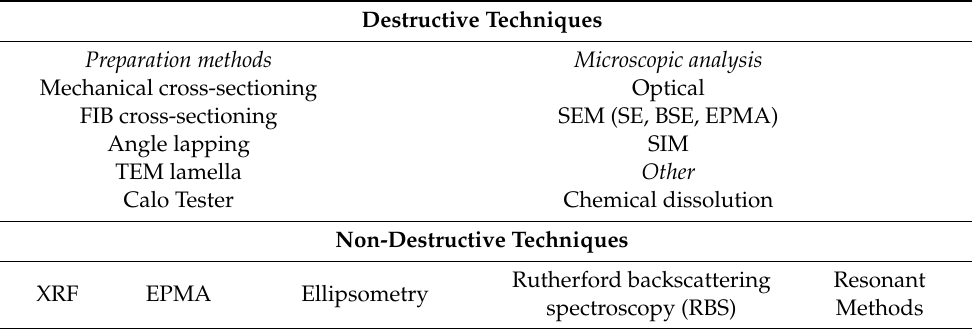
Table 1. Summary of the techniques covered in the